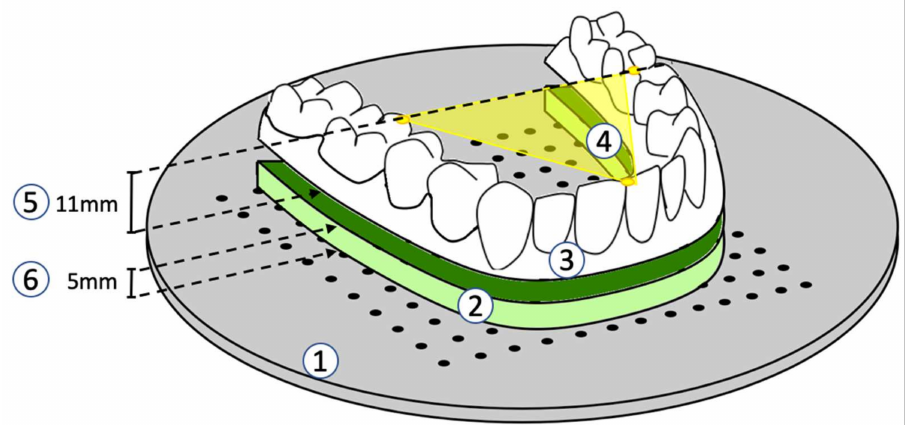
Figure 1. Thermoforming-Setup (1: model tray; 2: spacer; 3: acrylic dental arch model; 4: occlusal plane parallel to the model tray; 5: model height = 11 mm; 6: spacer height = 5 mm). The 3d-printed model was fabricated using a SLA printer (Form 2, Formlabs Inc., Somerville, MA, USA) at 100 micron resolution (100% infill) and using the Draft Resin (Formlabs Inc.). The model was oriented in a nearly vertical position to minimize